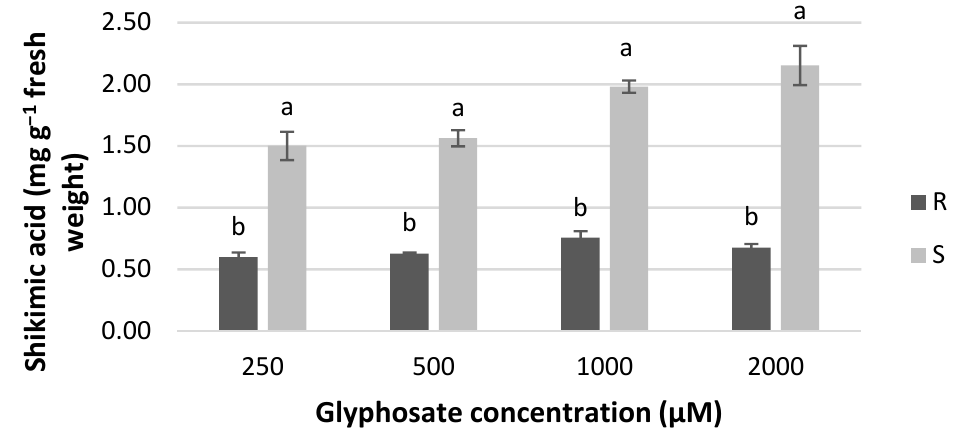
Figure 2. Shikimic acid accumulation of glyphosate-susceptible and -resistant Chloris radiata plants at different glyphosate concentrations. Vertical bars represent the standard error of the mean ( n = 3 technical replicates). Means with different letters within are statistically different at 95% probability determined by the Tukey test.